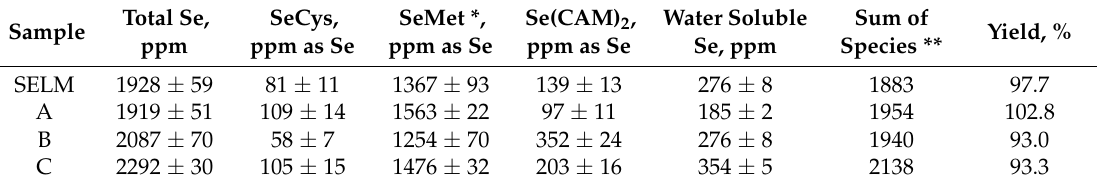
Table 3. Quantification of selenium species in studied yeast